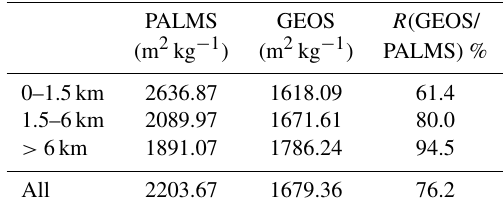
Table 2. Sea salt mass extinction efficient (MEE) for PALMS and GEOS and the ratio of MEEs between GEOS and PALMS in three vertical layers and in the whole atmosphere at RH